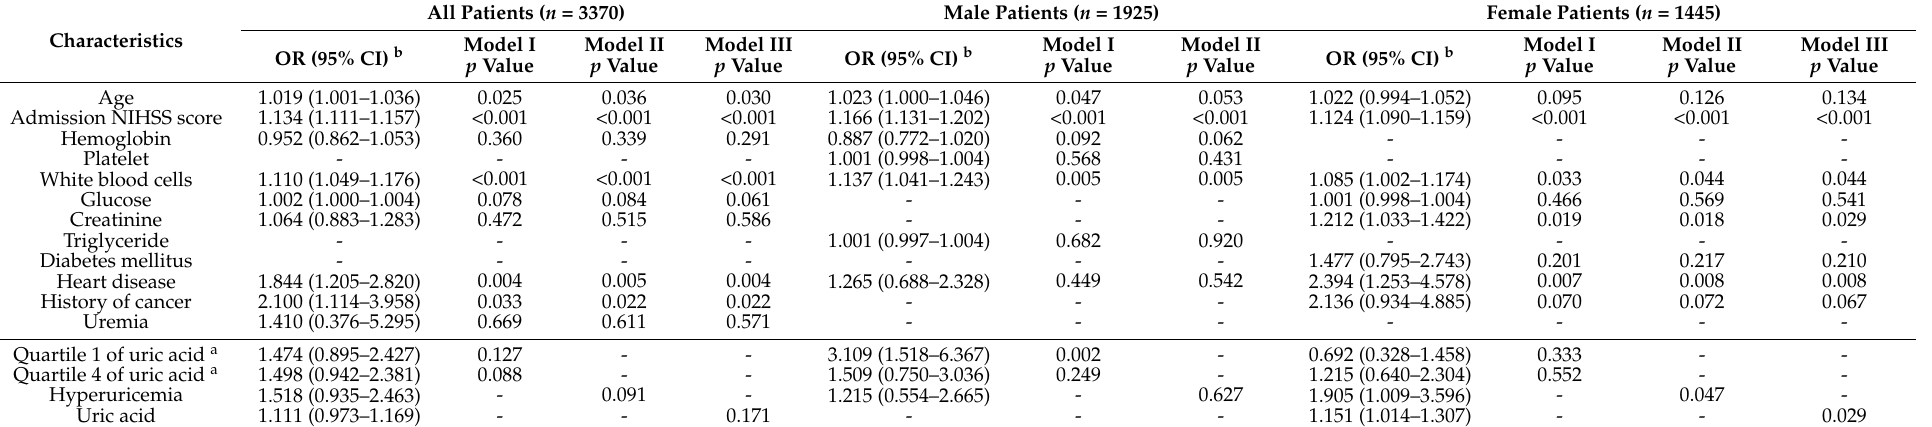
Table 8. Multivariable analysis of factors influencing death in 3370 patients with acute ischemic